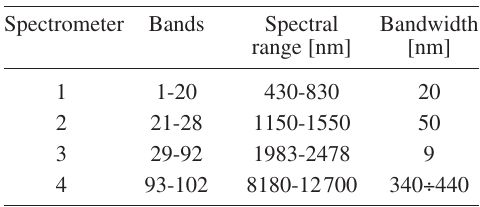
Table I. MIVIS spectral